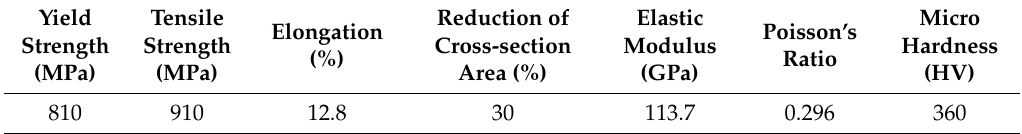
Table 2. Mechanical properties of TC7.